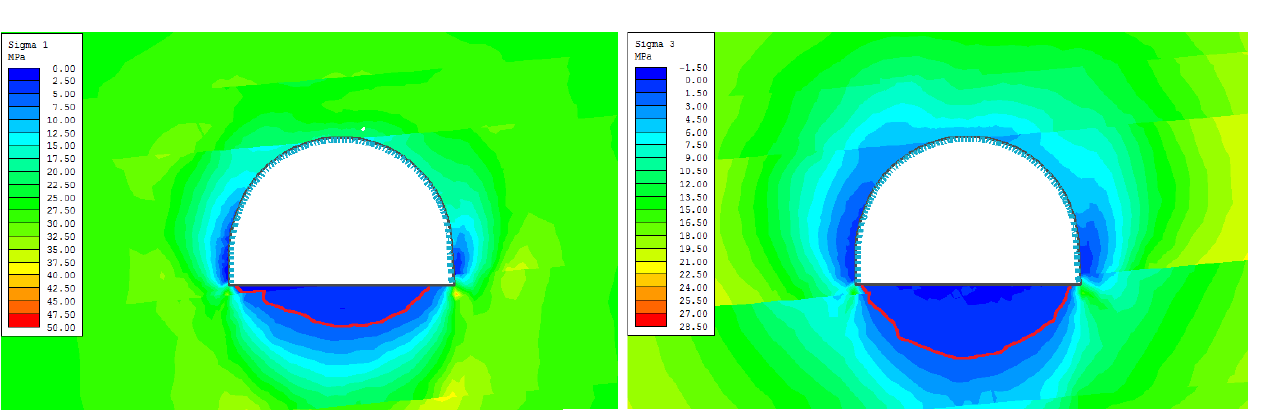
Figure 21. Extent of the failure zone beneath the dry floor of roadway D-2 — stage 1. In the second stage, the geomechanical parameters obtained from the laboratory tests on the rock samples after three hours of soaking (Table 5) were assigned to the failure zone contoured beneath the roadway floor. Next, the maps of the principal stresses were generated (Figure 22), and, again, the failure zone was contoured and enlarged up to 120 cm from the roadway floor.